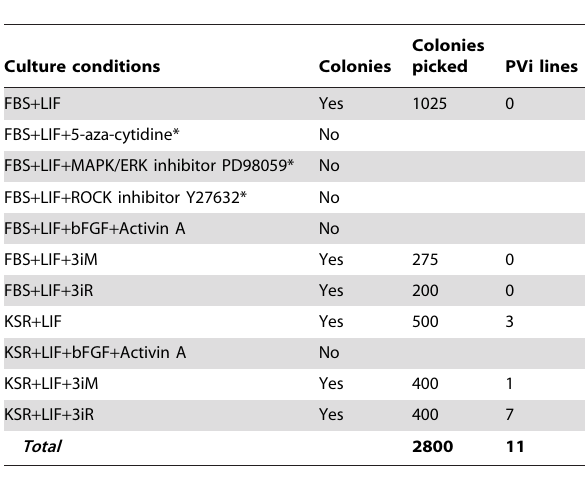
Table 1. Identification of culture conditions that promote generation of PVi